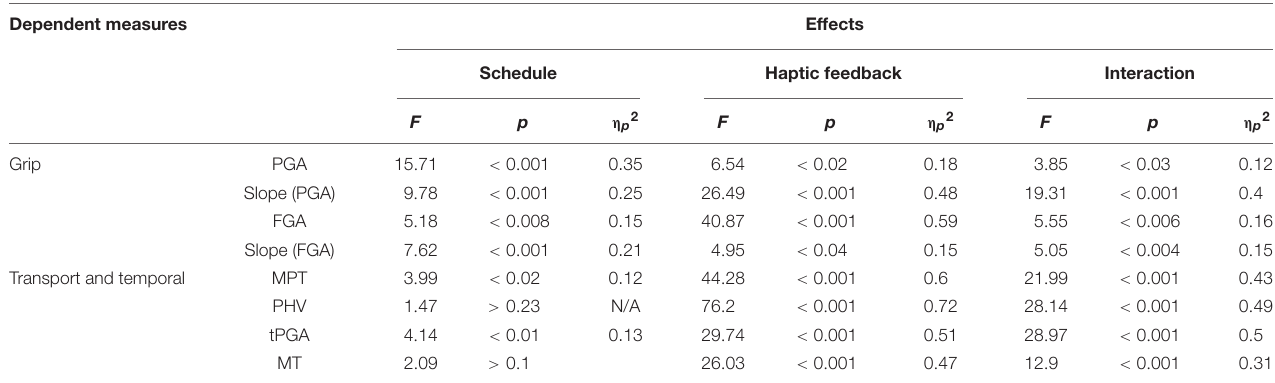
TABLE 1 | The effects tested with repeated measures ANOVA across the dependent measures. Dependent measures